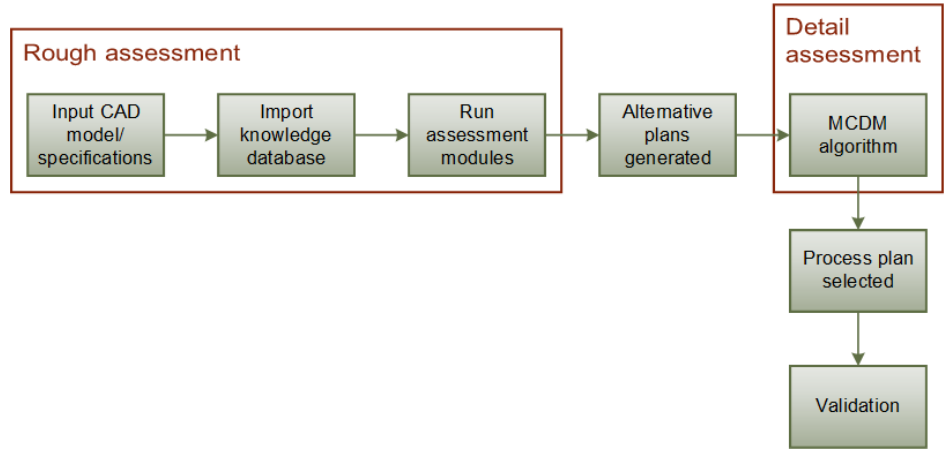
Figure 5. Block diagram of proposed method.